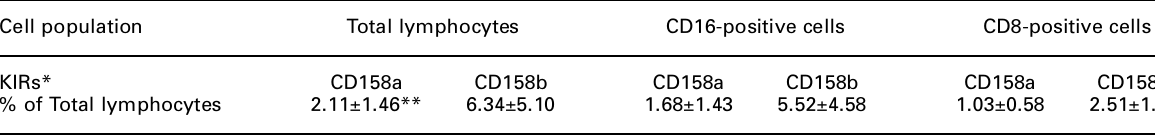
Table 1. The expression on PBMC of KIRs in healthy subjects ( n =14) Cell population